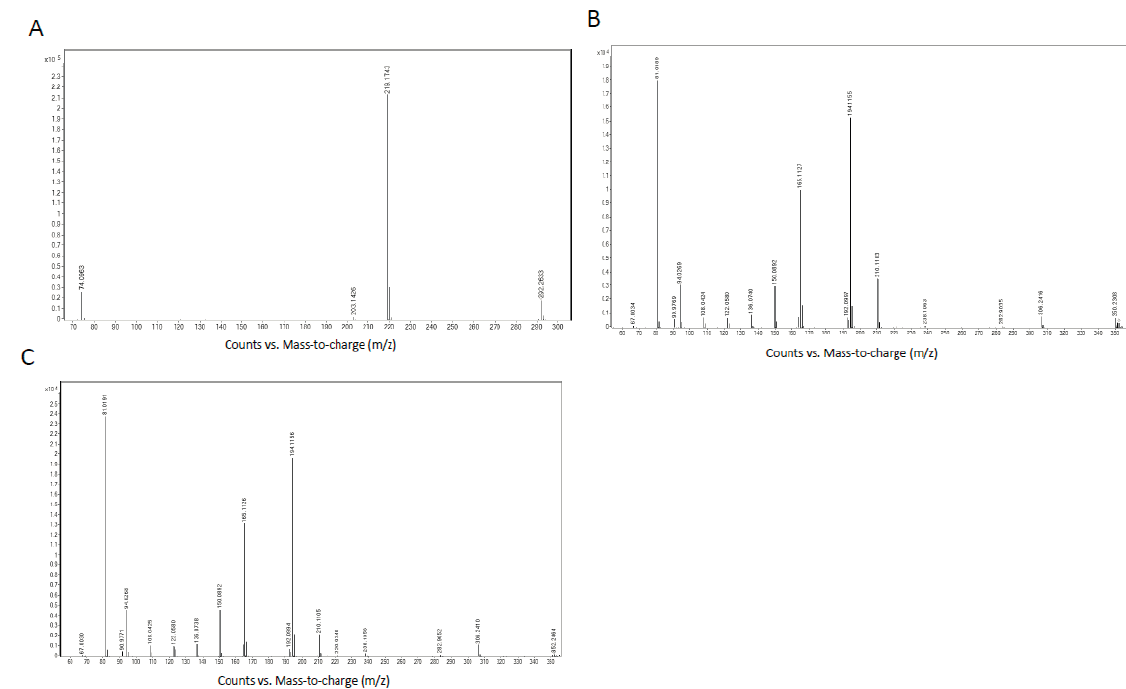
Figure A1. MS/MS spectra of metabolites with protonated molecular ions with ( A ) m / z 292.2645 eluted at 19.55 min; ( B ) m / z 352.2466 eluted at 28.5 min and ( C ) m / z 352.2466 eluted at 28.8